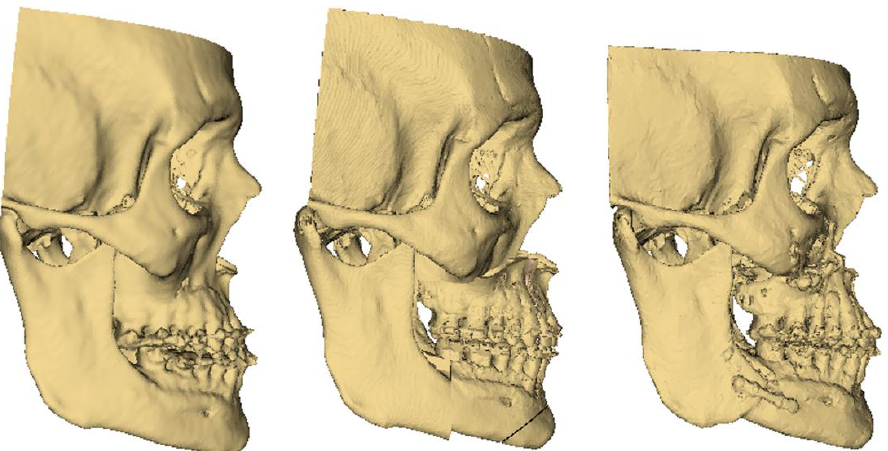
Figure 1. Preoperative ( left ), virtual surgical planning ( center ), and postoperative ( right ) models for an example patient.